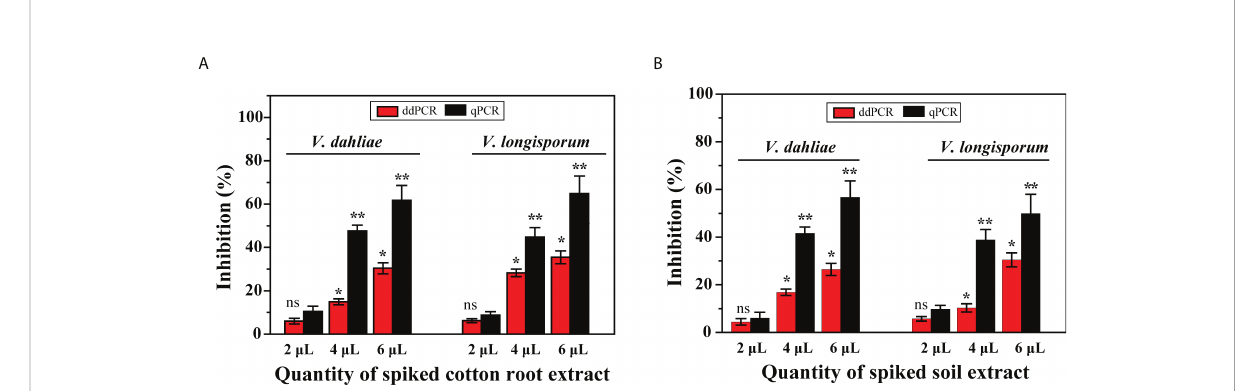
FIGURE 6 Effect of presence of DNA extracts from cotton roots and soil on quanti fi cation of V. dahliae and V. longisporum by ddPCR and qPCR assays. Samples were spiked with an equal amount of gDNA from both species and different quantities of (A) cotton root extracts and (B) soil extracts. Error bars represent standard error between three independent measurements of each run. Asterisks indicate statistically signi fi cant differences between treatments according to Student ’ s t -test. * and ** represent P ≤ 0.05 and P ≤ 0.01, respectively, compared with the inhibition control. ns, not signi fi